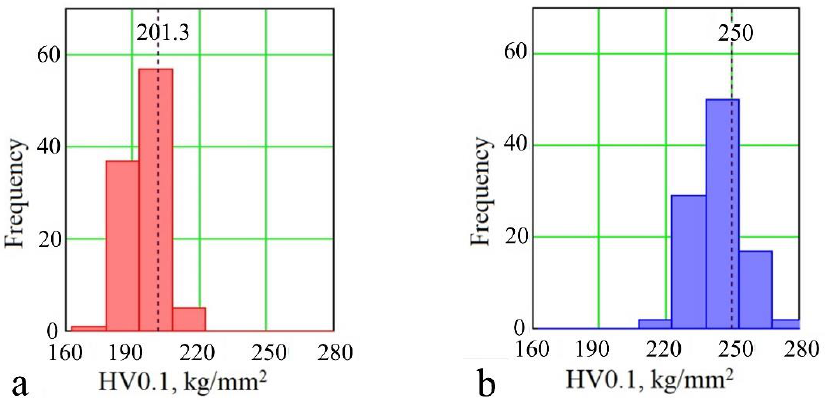
Figure 14. Diagrams of the frequency distribution of the microhardness values: ( a )—deposition welding without peening; ( b )—deposition welding with layer-by-layer peening.